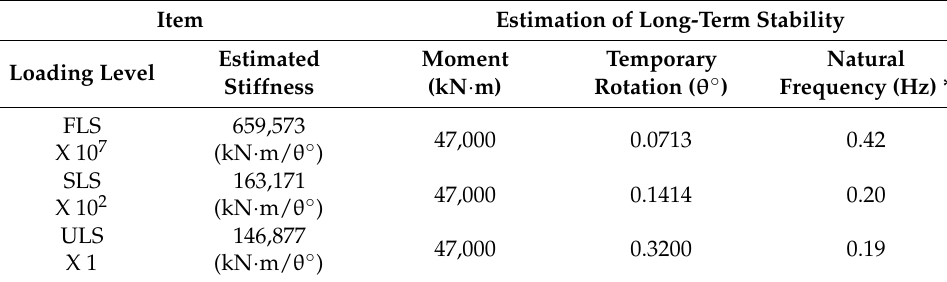
Table 8. Example of estimation of long-term stability of on-site